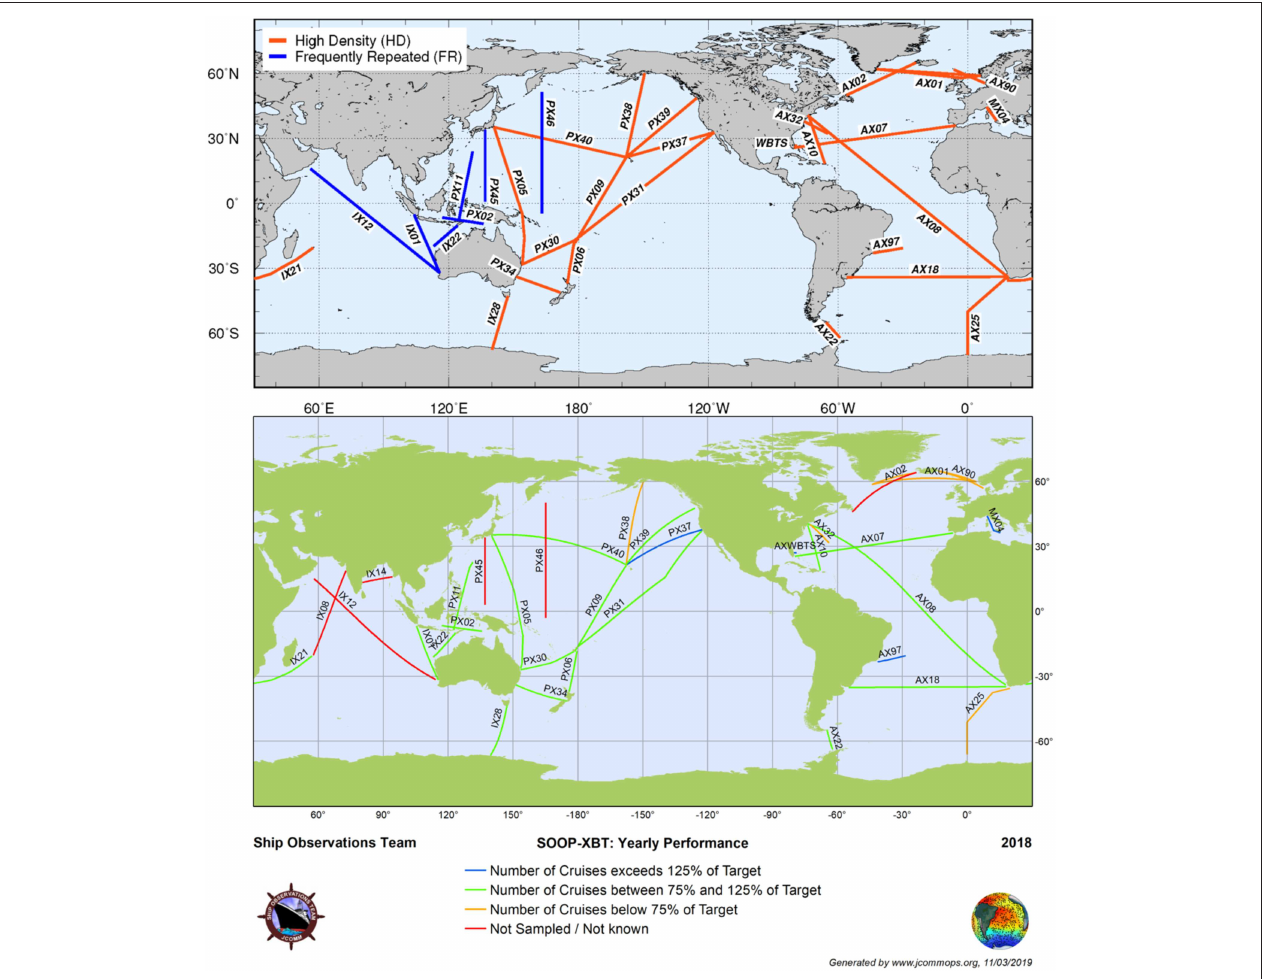
FIGURE 1 | (Top) Location of the HD/HR and FR XBT transects recommended by the XBT Science Team during the 5th Science Workshop held in October 2016. Table 1 provides a detailed explanation of each transect. (Bottom) Annual performance of the XBT network. Targets are set by the XBT Science Team and compared to realization numbers for each transect. The KPI defined by the total number of realization numbers divided by the number of all targeted realizations is 82% for 2018.